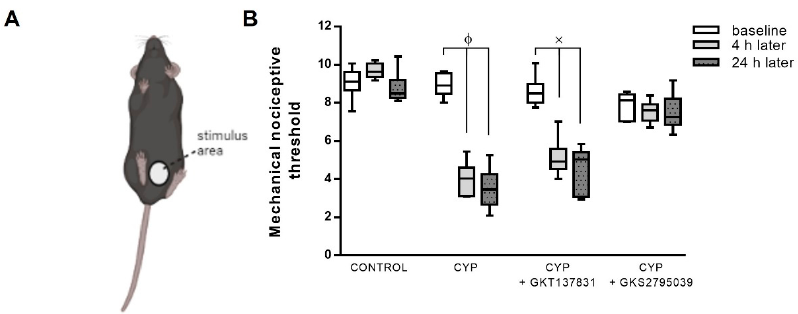
Figure 6. Nociceptive response to mechanical stimulation of the suprapubic region ( A ), an indicator of pain referred from the bladder, of the control (saline) and cyclophosphamide (CYP, 300 mg/Kg, ip, 24 h)-injected animals untreated or treated (three doses in 24 h) with the NOX1/4 inhibitor GKT137831 (5 mg/Kg, ip) or NOX2 inhibitor GSK2795039 (5 mg/Kg, ip). The responses ( B ) were quantified at the baseline (before any injections; white boxes), 4 h after saline or CYP injection (gray boxes), and 24 h after saline or CYP injection (gray dotted boxes). Summary data (mean ± SEM) represent n = 6 for all of the groups. Significance was tested by two-way ANOVA followed by multiple comparisons by Tukey’s post-hoc test. ϕ p < 0.05 vs. CYP-baseline; × p < 0.05 vs. CYP + GKT147831 baseline.